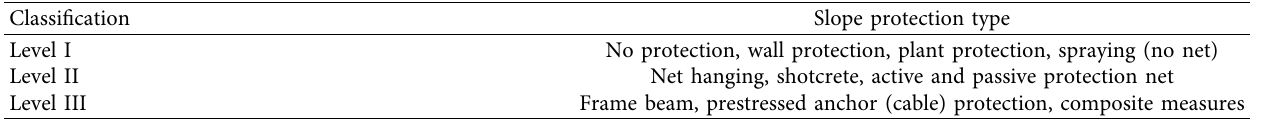
Table 3: Classification of slope protection